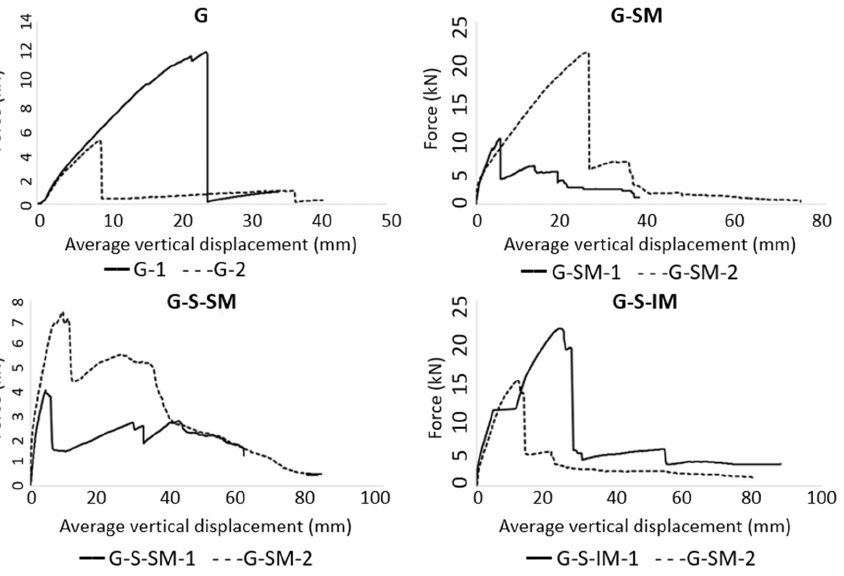
Figure 6. Force–average vertical displacement plots.